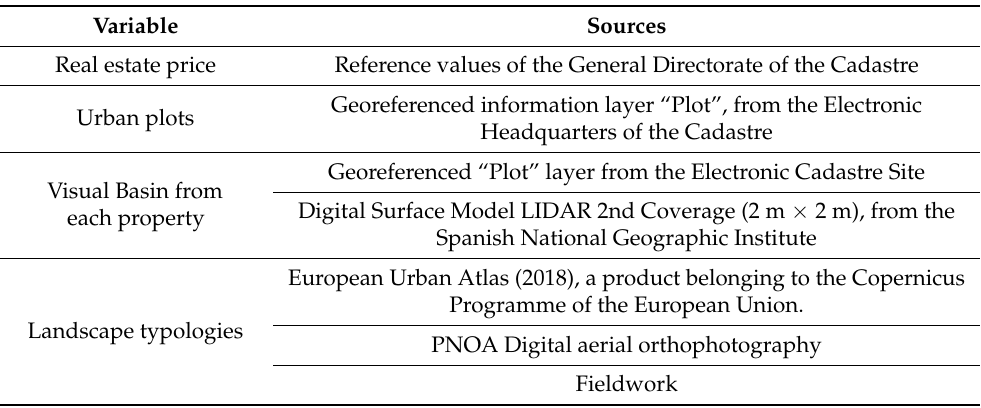
Table 3. Primary information sources of the processed